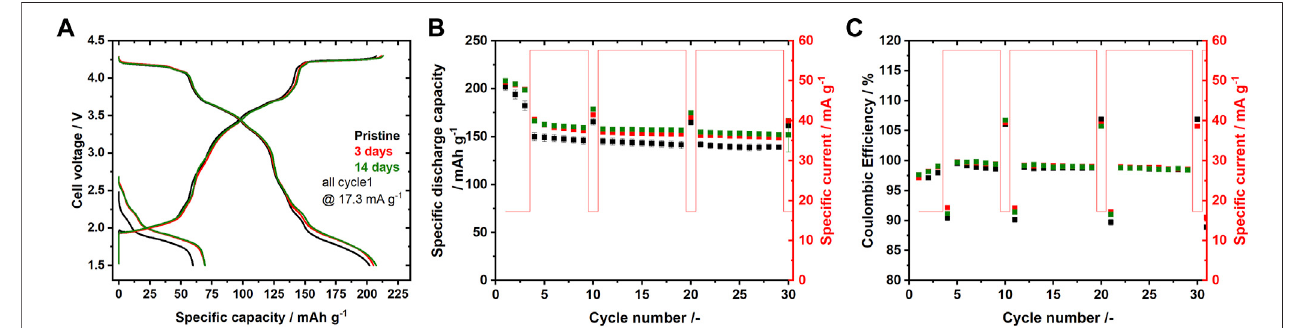
FIGURE 13 | (A) charge and discharge potential pro fi les of cells with pristine, 3 and 14 days stored material, (B) corresponding speci fi c discharge capacity for the fi rst 30 cycles and (C) coulombic ef fi ciency of the fi rst 30 cycles. For (B,C) every point represents an average of three cells, the standard deviation is presented as error